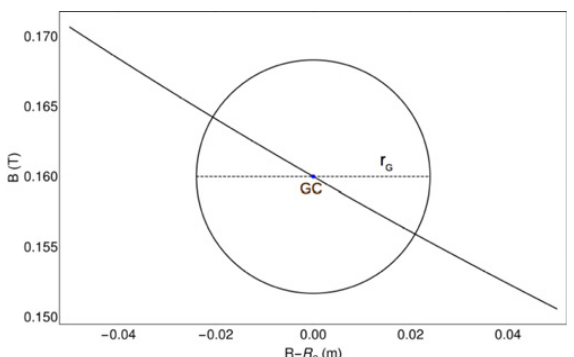
Figure 4. A visualization of the effect of the radial gradient ∂ B /∂ r in the drift region: The main component of the magnetic φ field is decreasing along the radial direction. Particles which gyrate around their guiding center (GC) experience an oscillating B-field. As the gradient is not linear, the mean magnetic field is not the same as the field at the guiding